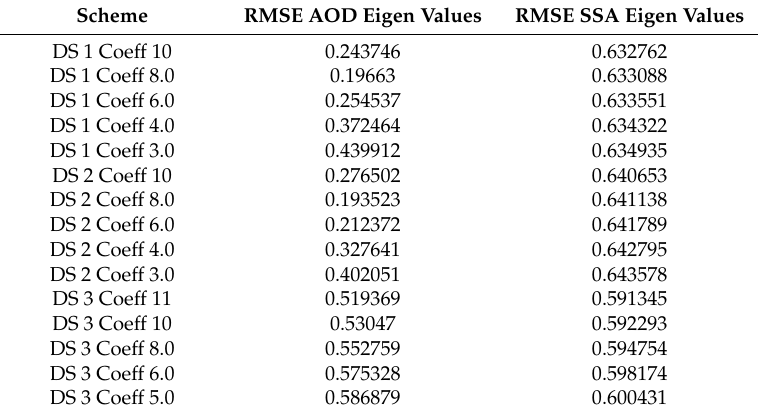
Table 11. RMSE for AOD and SSA of eigen values between all model simulations and MODIS for dust storm March 2013.